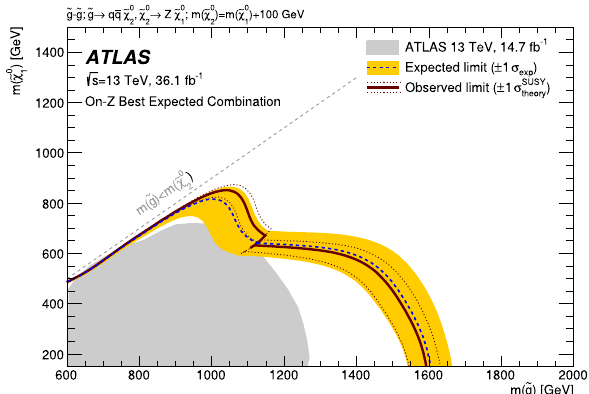
Fig. 15 Expected and observed exclusion contours derived from the best-expected-sensitivity combination of results in the on- Z m (cid:4)(cid:4) win- dows of SR-medium and SR-high for the ˜ g − ˜ χ 0 on-shell grid. The 1 dashed line indicates the expected limits at 95% CL and the surround- ing band shows the 1 σ variation of the expected limit as a consequence of the uncertainties in the background prediction and the experimental uncertainties in the signal ( ± 1 σ exp ). The dotted lines surrounding the observed limit contour indicate the variation resulting from changing the signal cross-section within its uncertainty ( ± 1 σ SUSY ). The shaded theory area indicates the observed limit on this model from Ref.